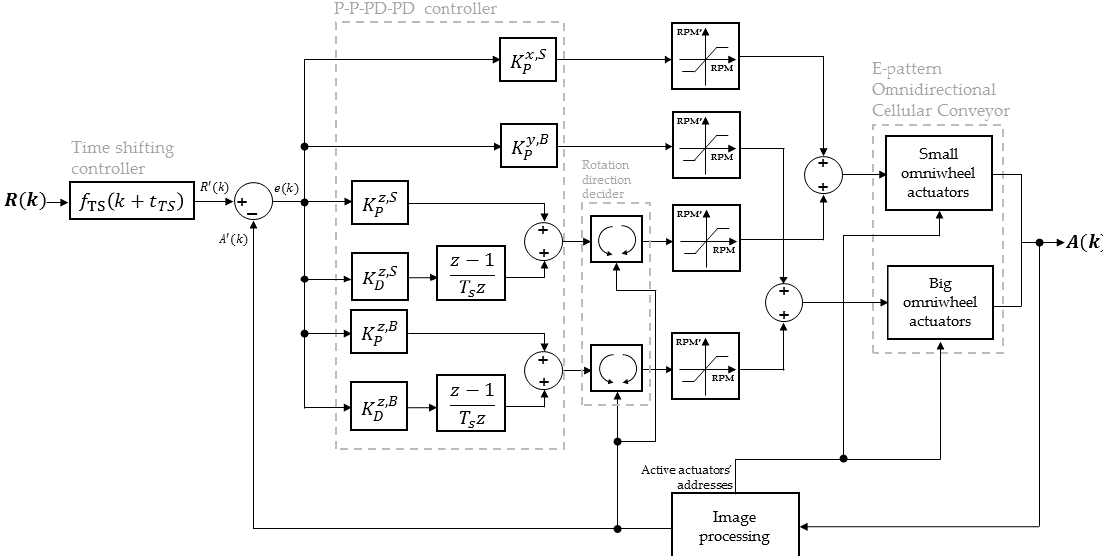
Figure 14. Block diagram of the control system designed and proposed for the EOCC system.